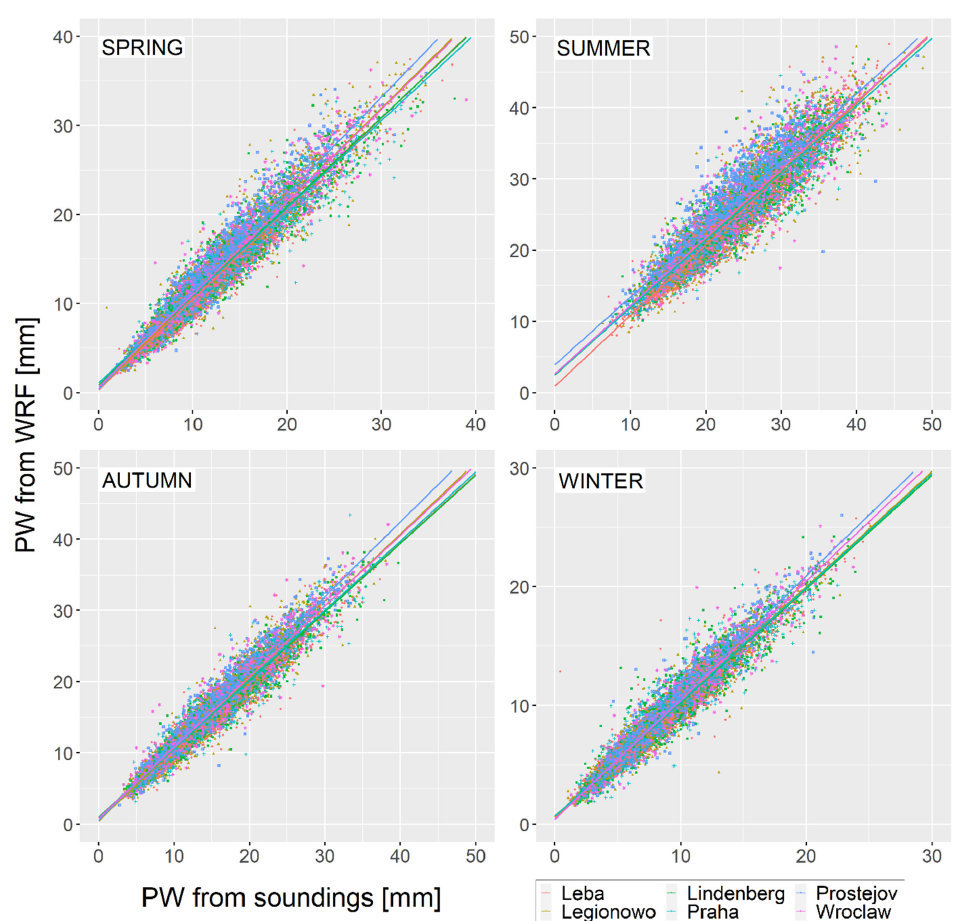
Figure 1. Comparison of PW data from the WRF model and data from atmospheric soundings between 2001 and 2010 in seasons.